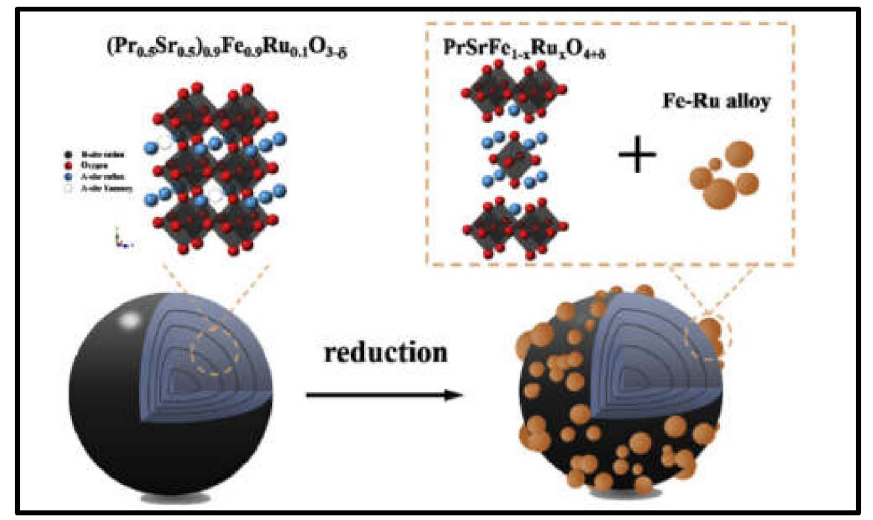
Figure 21. Schematic diagram of the morphology and crystal structure evolution of PePSFeRu after reduction (adapted from [300]).